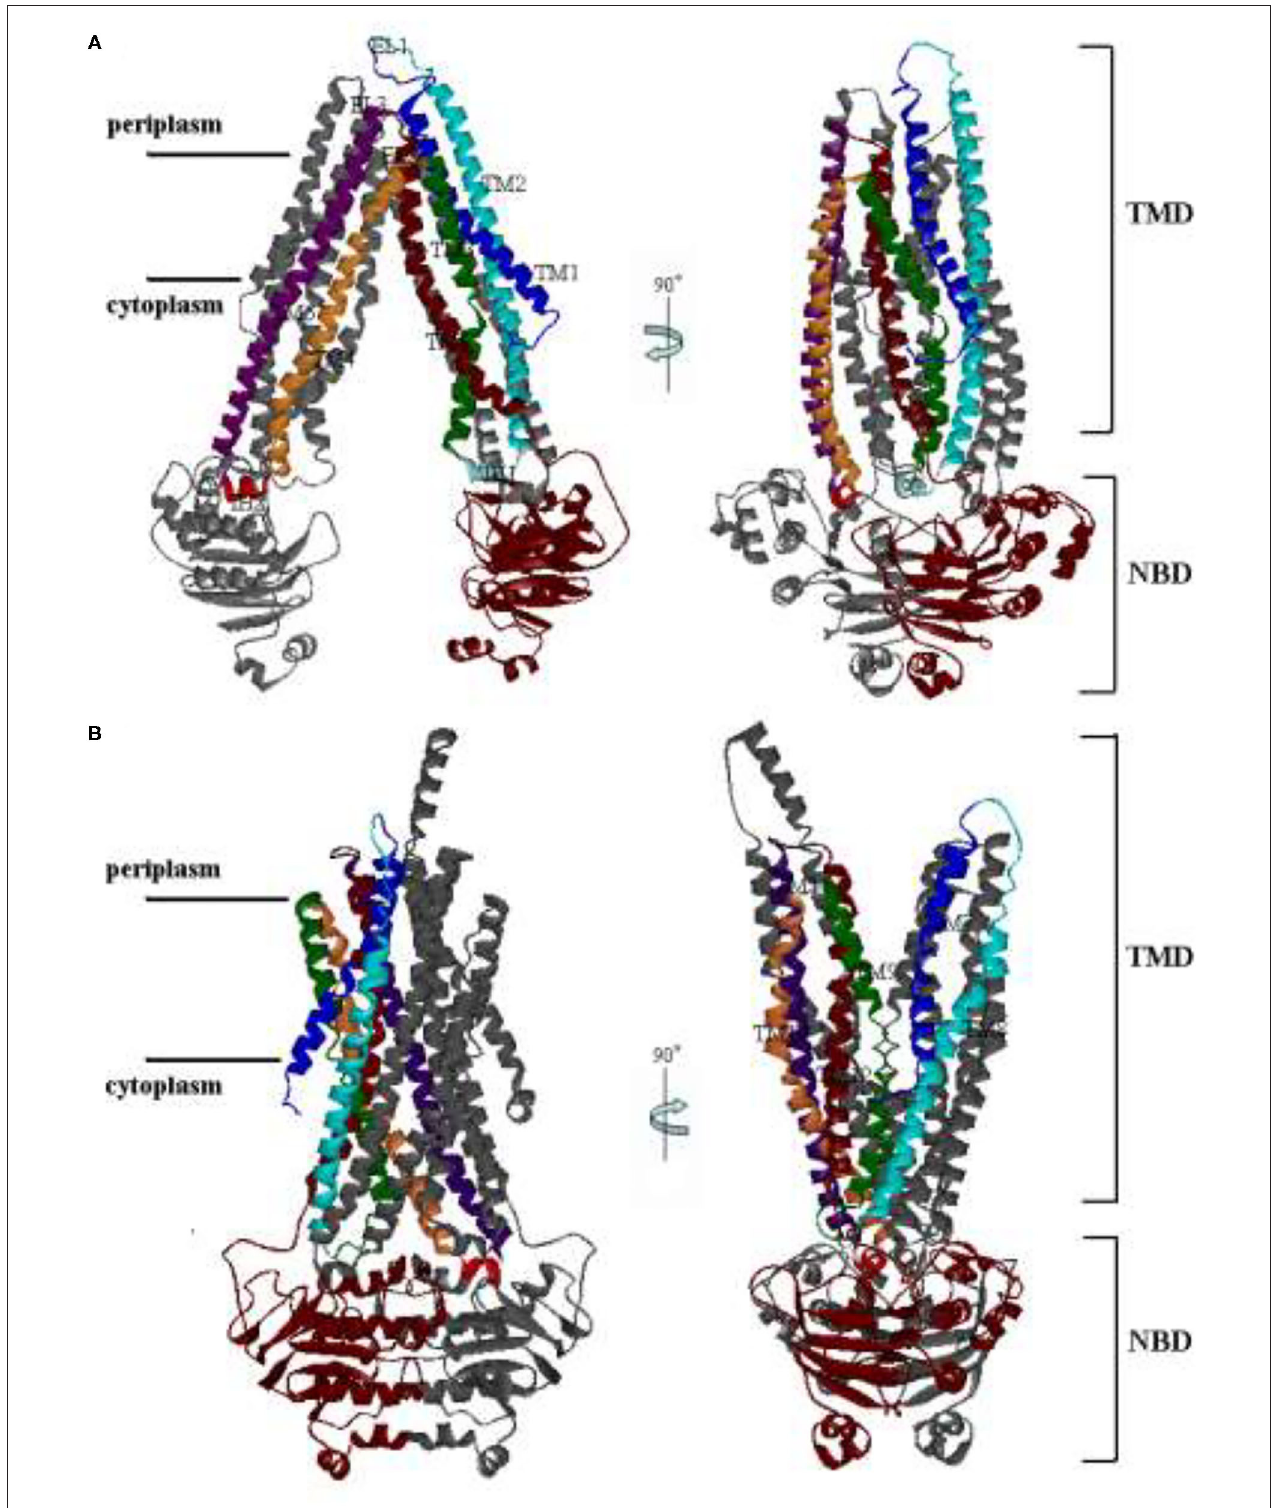
FIGURE 1 | The structures of human P-glycoprotein (P-gp). (A) The conformation of the inward-facing (IF) state by the Swiss Model; (B) The conformation of the outward-facing (OF) state with O’Mara. The right panel is related to the left one by a 90 ◦ rotation around the axis shown.